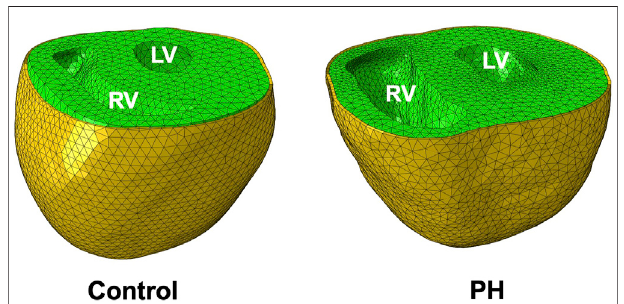
FIGURE 1 | Finite-element models of control and PH rat hearts (green) and pericardium (yellow). The PH RV dilates considerably in response to pathological pressure